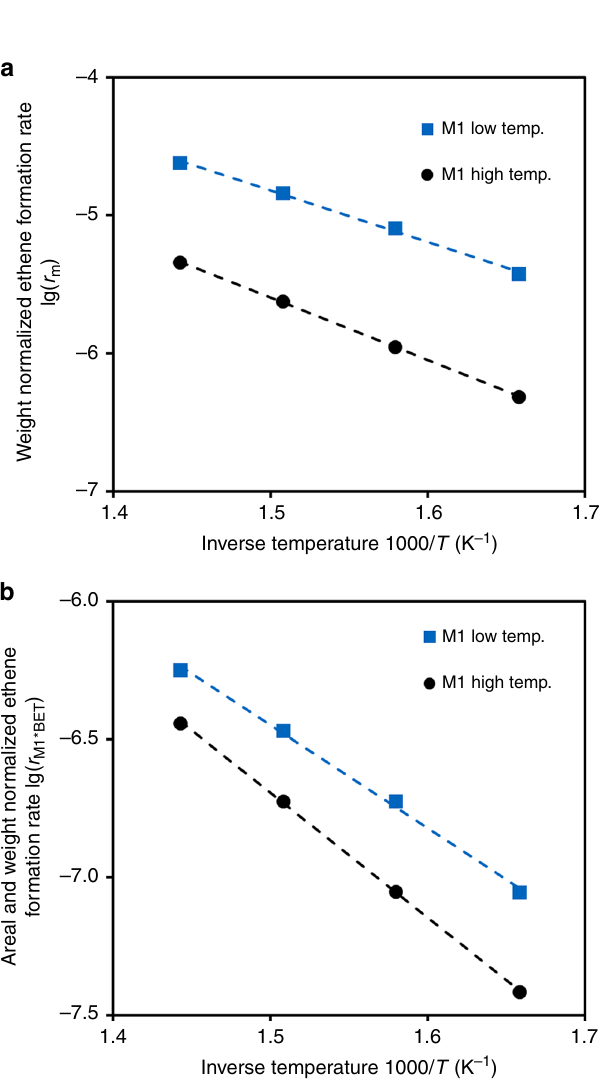
Fig. 3 Arrhenius plot for ethene formation over M1 catalysts. The rate of a MoVTeNbOx catalyst prepared by the new synthesis method (low temp, MoV 0.30 Te 0.05 Nb 0.05 O x ) is compared with the rate over M1 prepared by standard method as in ref. 19 (high temp, MoV 0.30 Te 0.06 Nb 0.08 O x ). Rates normalized per mass of catalyst ( a ) and surface of M1 ( b ). T = 330 – 420 °C, p = 1 bar( a ), WHSV = 6.8 h − 1 (high temp sample), 14.5 h − 1 (low